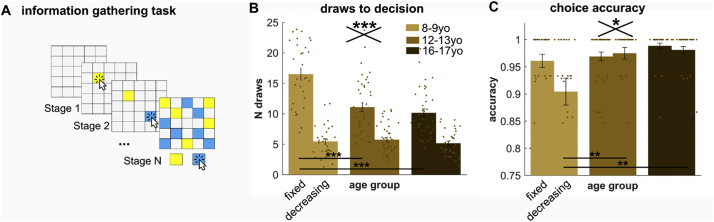
Increased information gathering in children. (A) Task procedure: Youths played an information gathering task in which they were allowed to overturn as many cards as they needed before making a decision and declaring whether the yellow or blue cards formed the majority of the 25 originally covered cards. (B) The 8–9 year-old children opened more cards than the early (12-13yo) and late (16-17yo) adolescents in the fixed condition, in which opening cards was not associated with explicit costs. There was no difference in sampling in the decreasing condition, in which their earnings decreased when opening more cards. (C) Moreover, children were slightly worse at choosing the colour that was currently more plentiful in the decreasing condition, indicating worse inference abilities. *** p < .001; ** p < .01; * p < .05; yo year-olds. (For interpretation of the references to colour in this figure legend, the reader is referred to the web version of this article.)